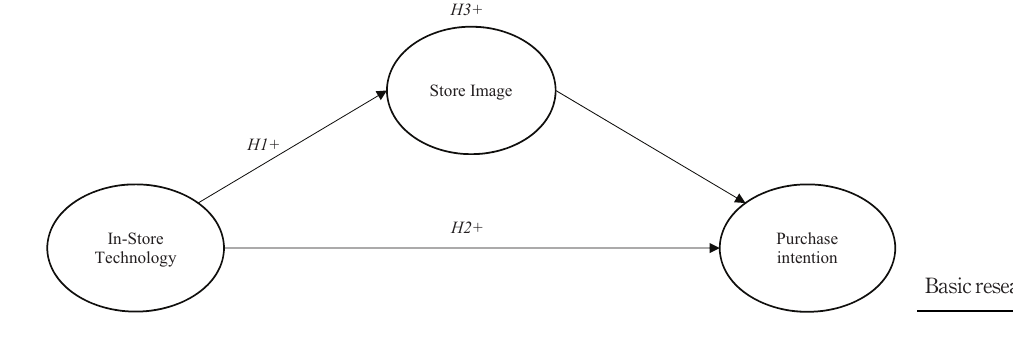
Figure 1. Basic research